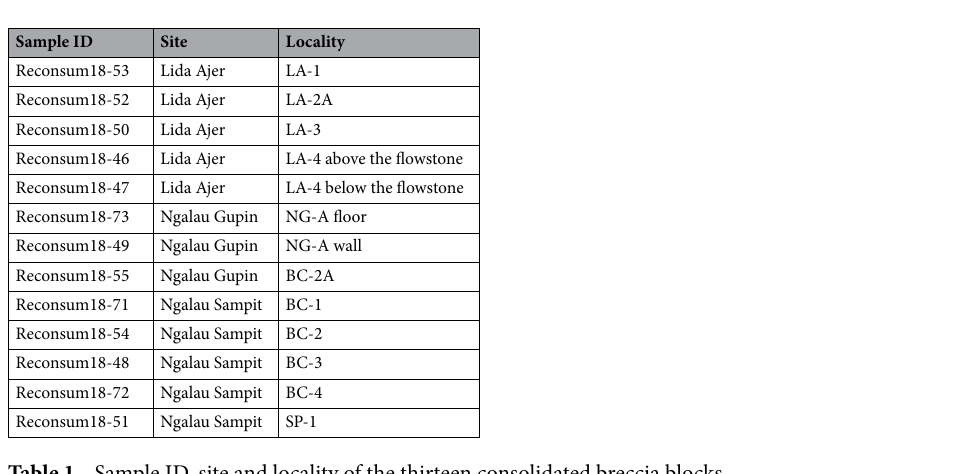
Table 1. Sample ID, site and locality of the thirteen consolidated breccia